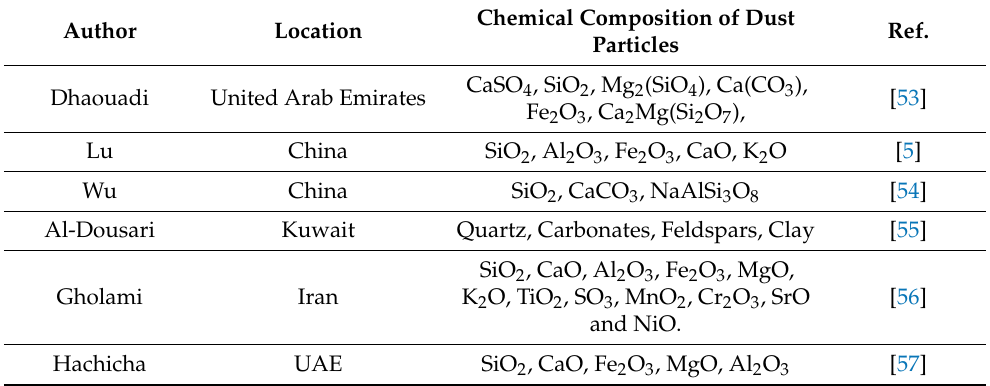
Table 1. Dust particle composition in different